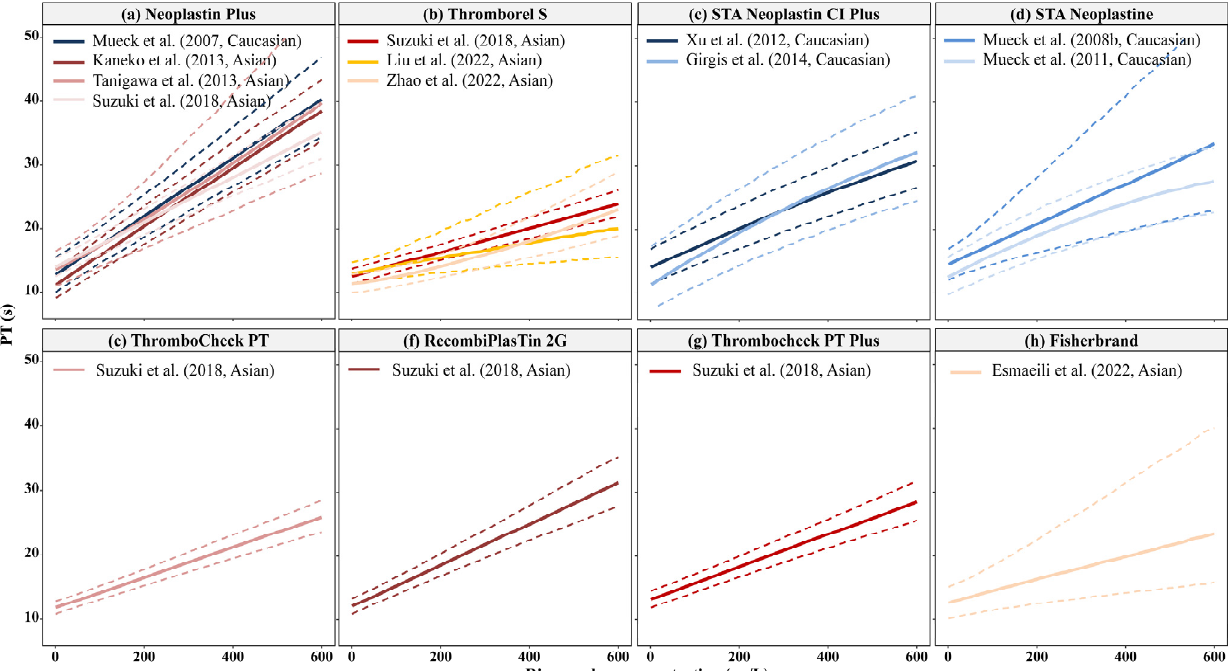
Figure 3. Relationship between prothrombin time (PT) and rivaroxaban concentration between Asian and Caucasian populations using different PT thromboplastin reagents. The reagents used in the included studies were the following: ( a ) Neoplastion Plus, ( b ) Thromborel S, ( c ) STA Neoplastin CI Plus, ( d ) STA Neoplastine, ( e ) ThromboCheck PT, ( f ) RecombiPlasTin 2G, ( g ) Thrombocheck PT Plus, and ( h ) Fisherbrand. The bold, solid, and dashed lines represent the median, 5th, and 95th percentiles of the simulated PT-rivaroxaban concentration profiles in each model, respectively. Zdovc et al. reported PT models with a reagent named Thromborel S. Because the PT-time profile of that model was significantly different from the others (Supplementary Figure S3), it was excluded from the subgroup analysis [19,20,22–27,30,34,38].